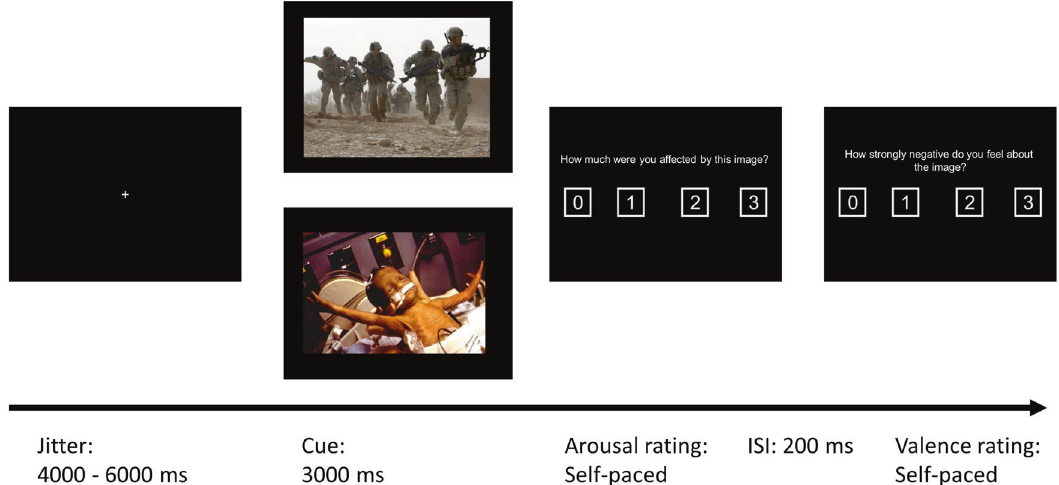
Fig. 1 Task design. After a variable jitter combat or negative affective IAPS stimuli were presented for 3 s at the beginning of each trial. Arousal and valence rating (order randomized) each with a 4-point-scale were followed with a 200 ms interval ( fi xation cross, not shown) between the ratings.